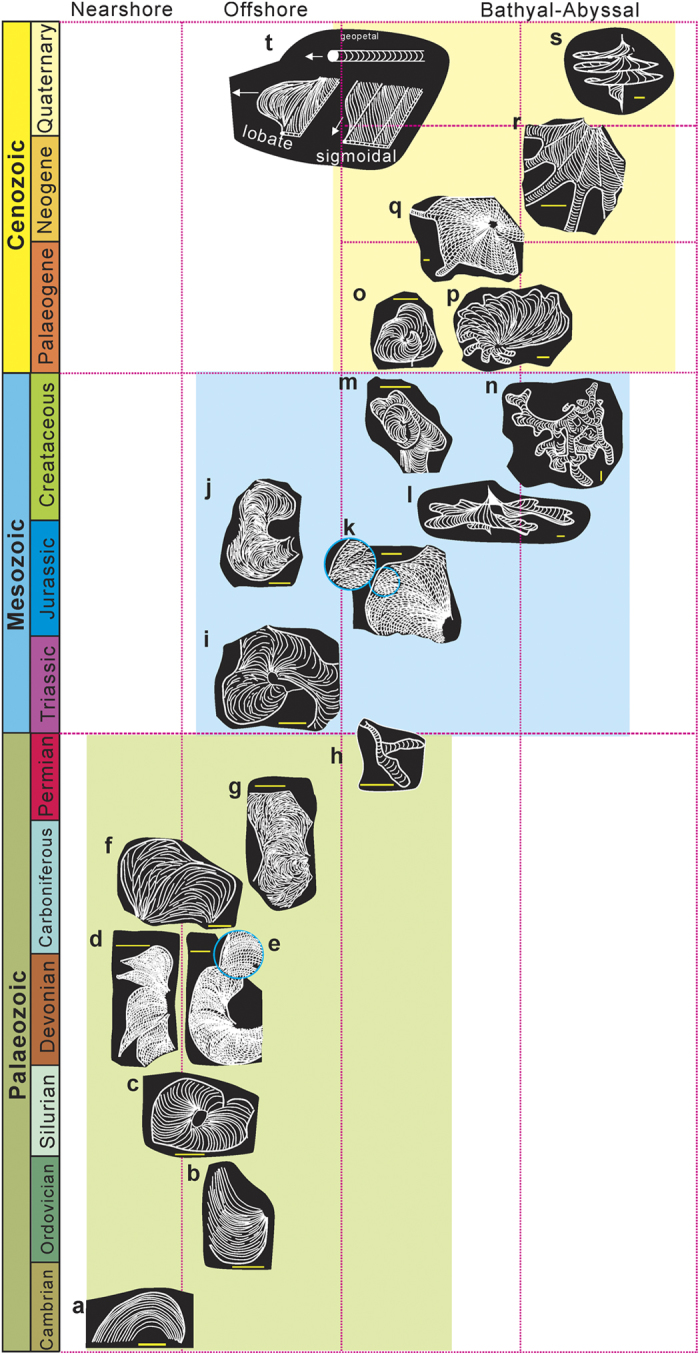
Morphological macroevolution of Phanerozoic Zoophycos.(a) cocks-tail shaped spreiten with J-shaped primary lamellae, Cambrian, USA48. (b) cocks-tail shaped spreiten with J-shaped primary lamellae, Ordovician, China49. (c) Spiraling circular spreiten of one whorl, Devonian, Bolivia19. (d) Centrifugal, alate spreiten, Devonian, Libya14. (e) Centrifugal, spiraling spreiten, Devonian, Libya14. (f) Spiraling tongue-like spreiten, Pennsylvanian, USA50. (g) Ambivalent backfilled spreiten, Pennsylvanian, Austria14. (h) Spiraling elongate lobate spreiten, Permian, China23. (I,j) Spreiten made of centripetal U-shaped protrusive burrows, Triassic and Jurassic, Germany14. (k) Irregular centripetal spiraling spreiten, Jurassic, France14. (l) Spiraling gently lobed circular spreiten, Jurassic, France1. (m) Spiraling lobate spreiten in slightly conical outline, Cretaceous14. (n) Irregular spiraling lobate spreiten, Cretaceous51. (o,p) Regular spiraling lobate spreiten, Eocene, Italy1451. (q) Rhizocorallium-like spiraling spreiten, Oligocene, New Zealand1114. (r) Irregular spiraling spreiten with long lobes, Miocene, Turkey52. (s) 3-D morphology of Zoophycos from Quaternary deep-sea deposits10. (t) trace making paradigm of Zoophycos, showing production of sigmoidal secondary lamellae and U-shaped protrusive burrows14. All scale bar, 5 cm.